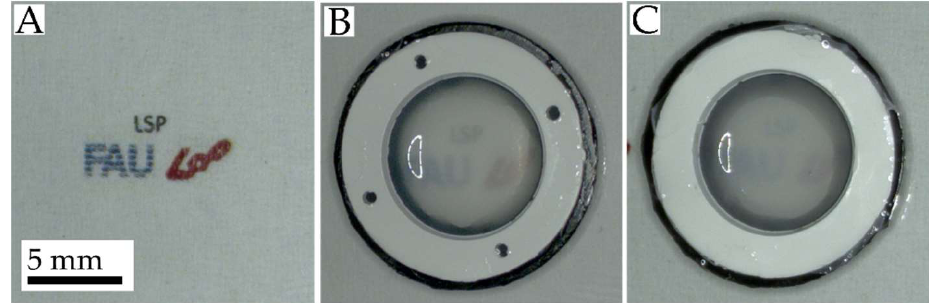
Figure 7. Examples of the transparency of nanofibrous scaffolds: ( A ) blank image as a reference. ( B ) Scaffold consisting of nanofibers with fiber diameters of 35 nm and ( C ) 167 nm. Scaffolds with a thickness close to 10 µm were chosen and moistened in PBS before image recording.